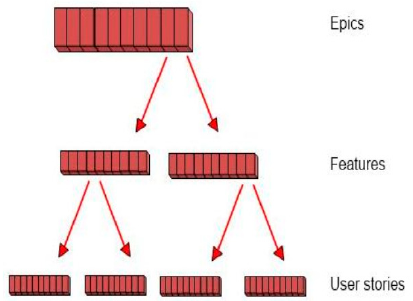
Figure 2. Hierarchical view of requirements.